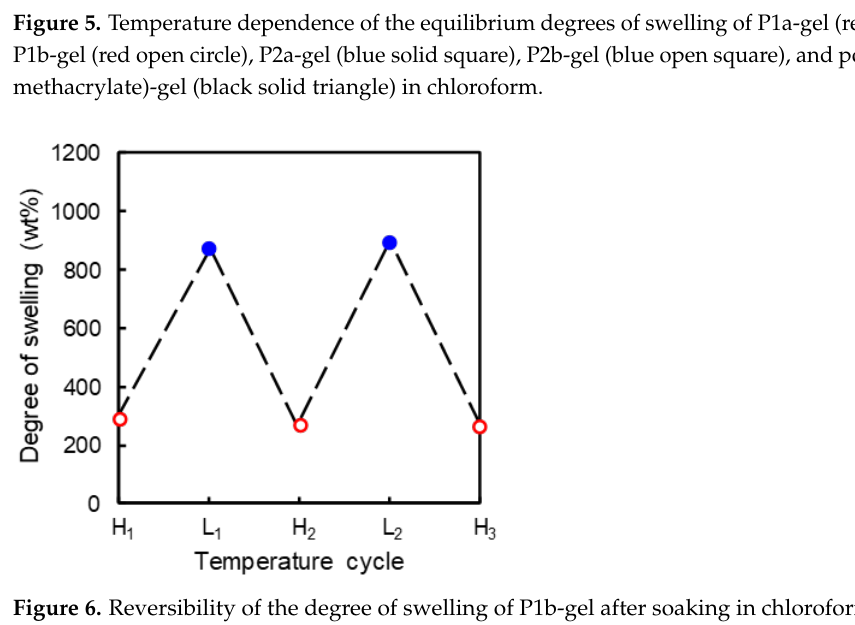
Figure 6. Reversibility of the degree of swelling of P1b-gel after soaking in chloroform at 45 °C for 24 h (Hn, red open circle) and at −30 °C for 24 h (Ln, blue solid circle).